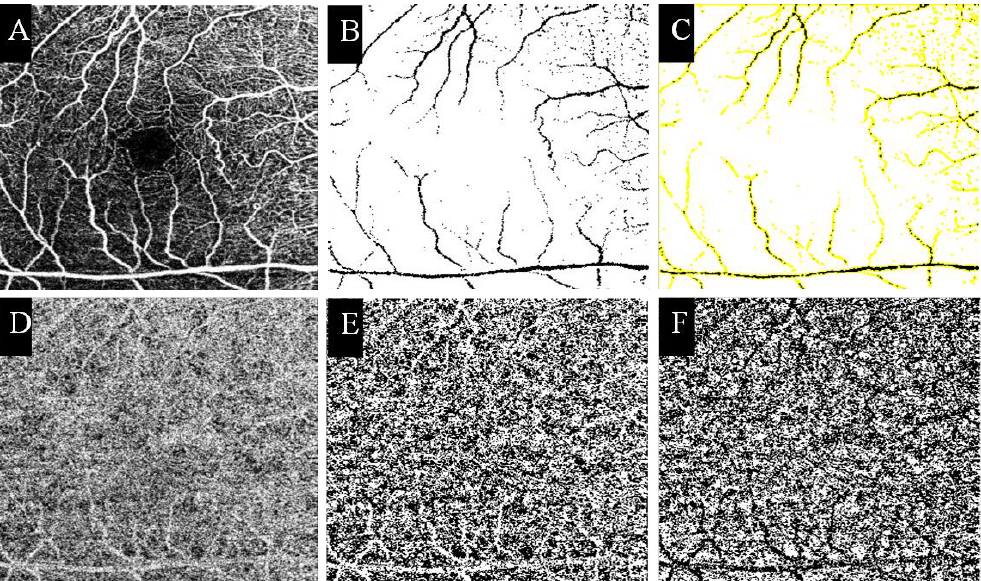
Figure 3. Measurement of the CCP vessel density using the Fiji software. SCP layer images from OCTA ( A ). The image was thresholded, and only large vessels are shown ( B ). We subsequently created ( B ) a masking tool to prevent projection artifacts ( C ). CCP layer from OCTA ( D ). The image was binarized using Otsu’s local-threshold method ( E ). Subsequently, the image (E) was masked by another image ( C ) to remove the influence of the large vessel on the choroid ( F ). SCP, superficial capillary plexus; CCP, choriocapillaris.